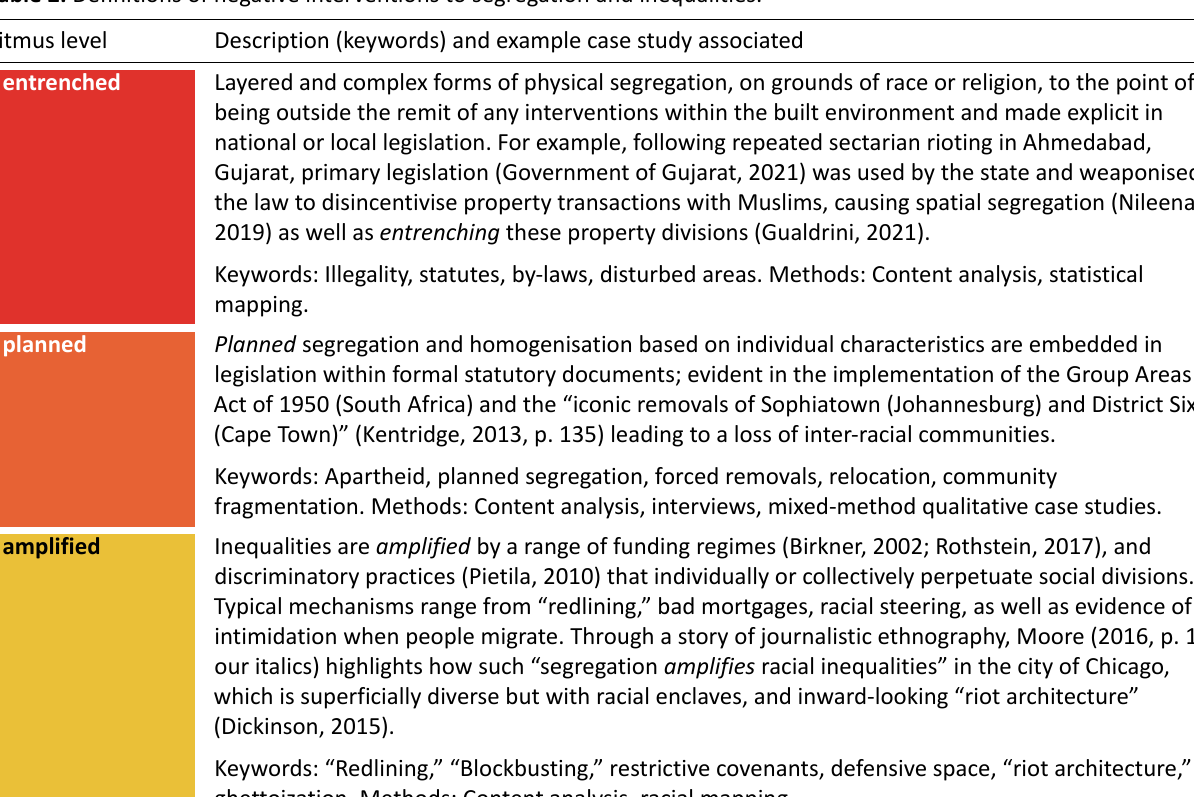
Table 2. Definitions of negative interventions to segregation and